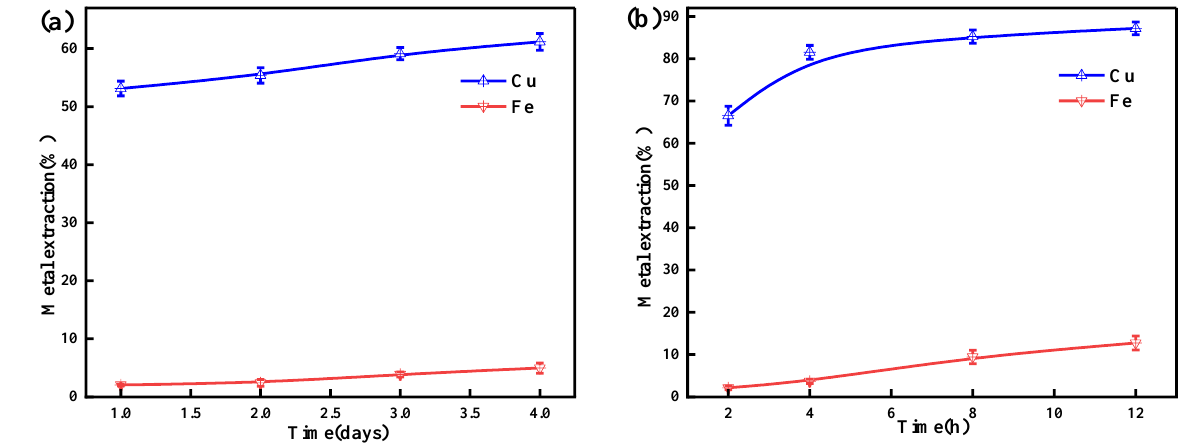
Figure 12. Effect of leaching time on metal extractions in agitation leaching: ( a ) magnetic concentrate; ( b ) magnetic tailing.